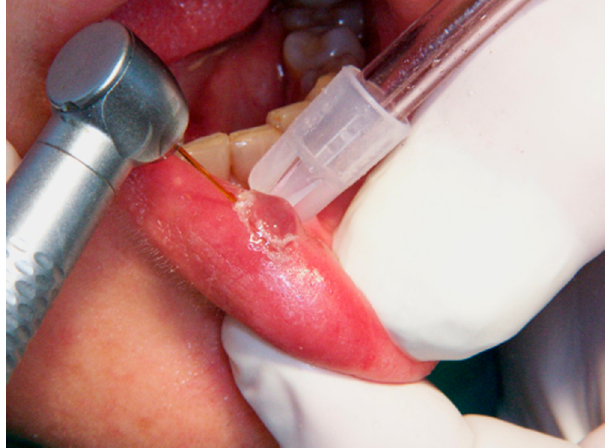
Figure 2. The lesion’s resection limit is indicated by the Er,Cr:YSGG laser around the surgical site.